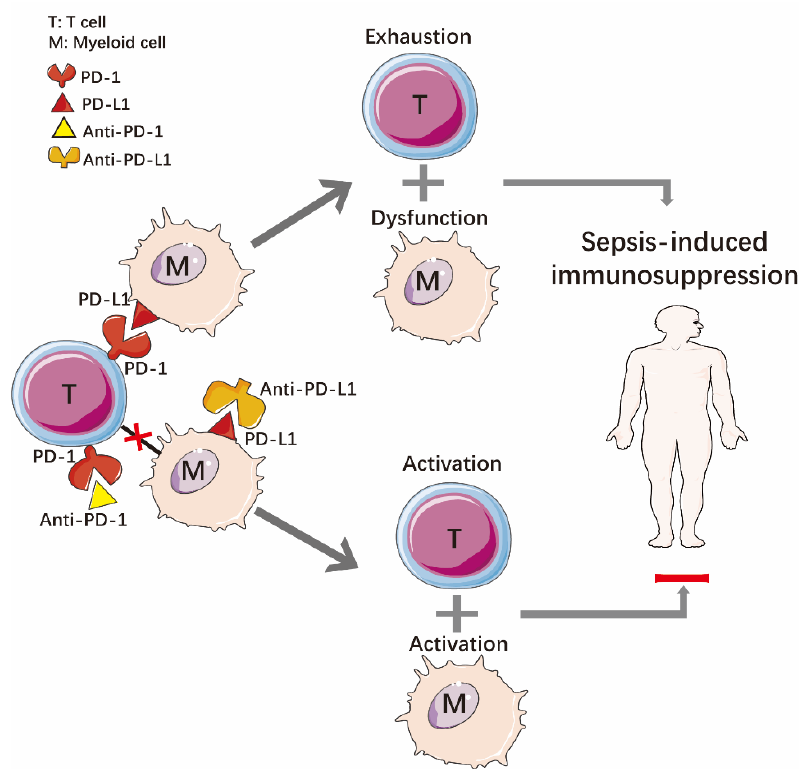
Figure 4. Blocking Programmed Death Receptor-1 and Programmed Death Ligand-1 (PD-1/PD-L1) signaling reverses the immunosuppression in sepsis.